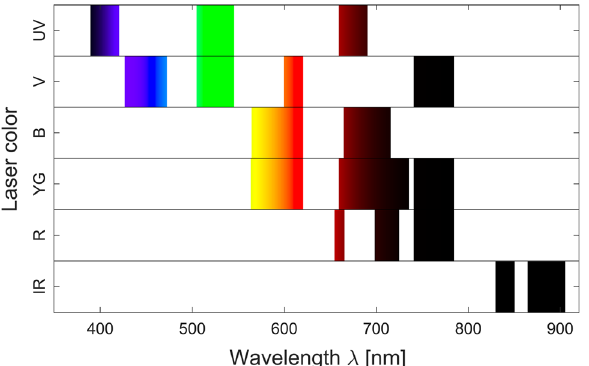
Figure 6. Lasers and detectors configuration of Beckman Coulter CytoFLEX LX machine. The instrument used in this study is equipped with 6 lasers (350 nm ultraviolet, 405 nm violet, 488 nm blue, 561 nm yellow/ green, 638 nm red, 808 nm infrared) with each laser having a specific set of optical bandpass filters to collect fluorescence